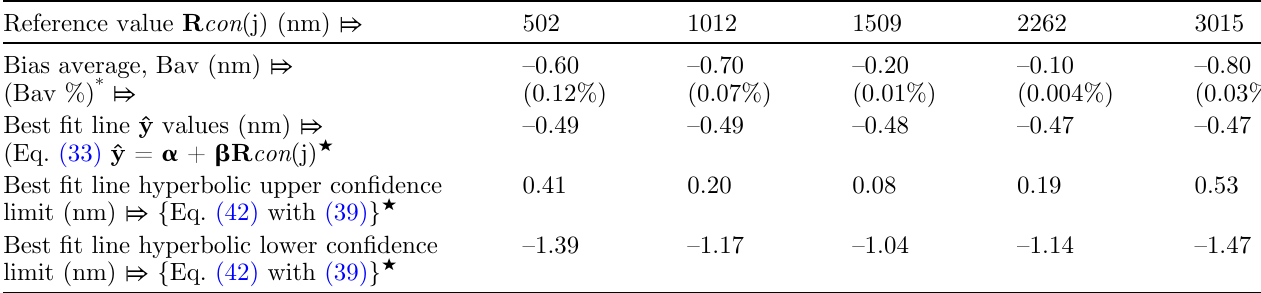
Table 7. Example 4. FAC-1; system A; linear regression analysis results; best fi t